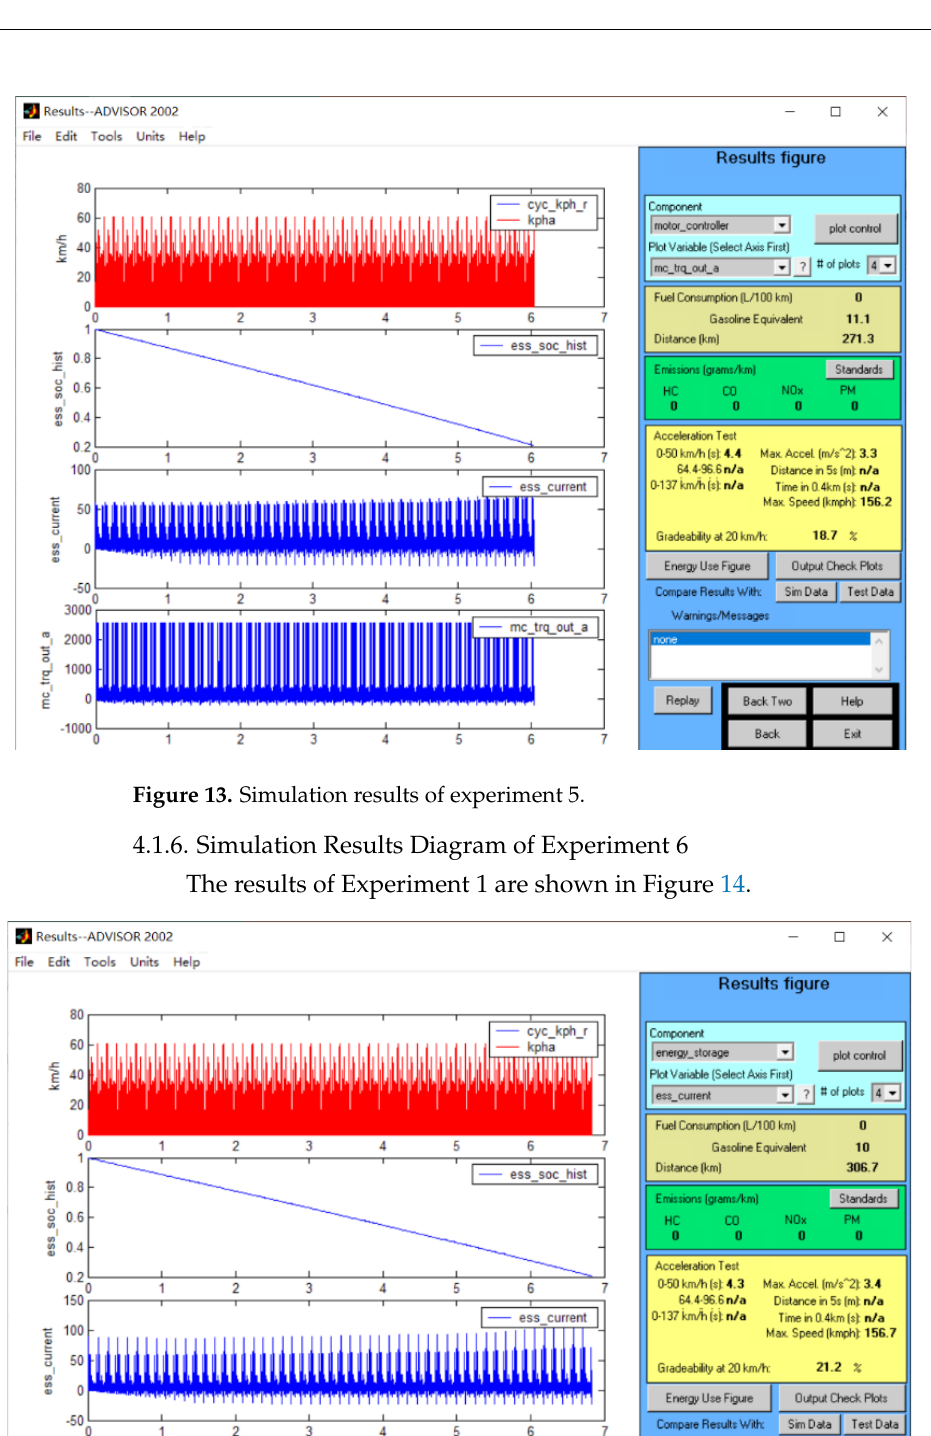
Figure 12. Simulation results of experiment 4.